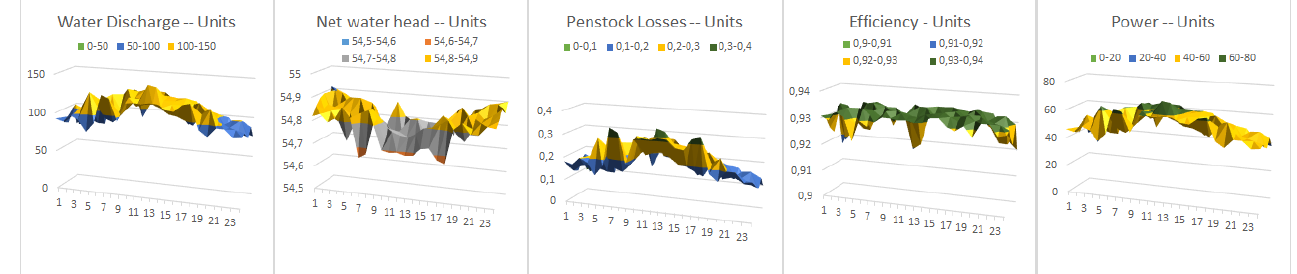
Figure 9. Real Genetic Algorithm—RGA. Results of Water discharge (m 3 /s). Net water head (m). Penstock (m). Efficiency (%) and Power generated (MW/h). Daily dispatch (24